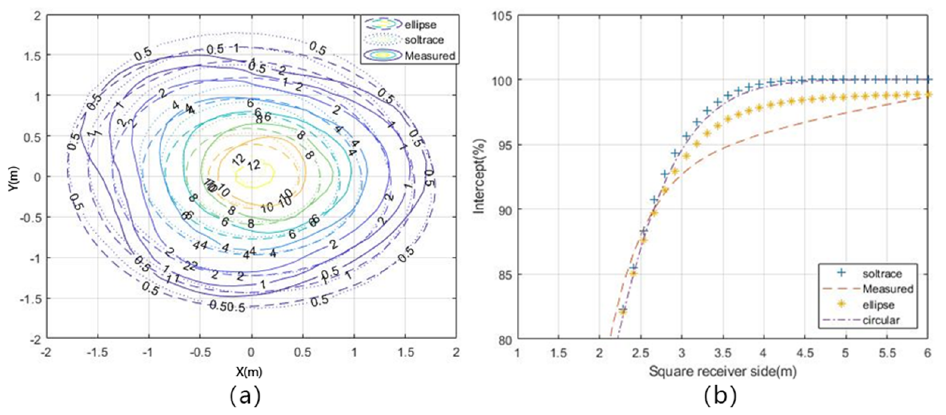
Figure 7. ( a ) Contours of the measured and computed flux distribution (kW/m 2 ): Heliostat #1, ( b ) measured and computed intercepts vs. the side length of a square receiver: Heliostat #1 .